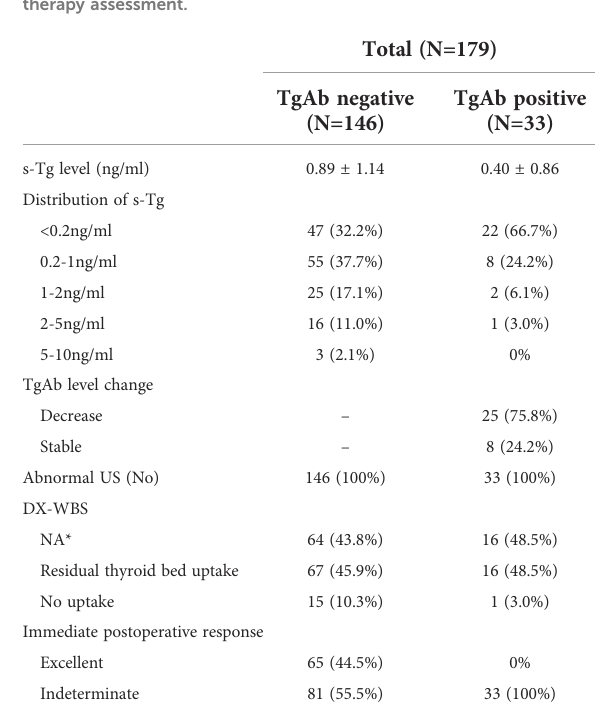
TABLE 2 The results of immediate postoperative response to therapy